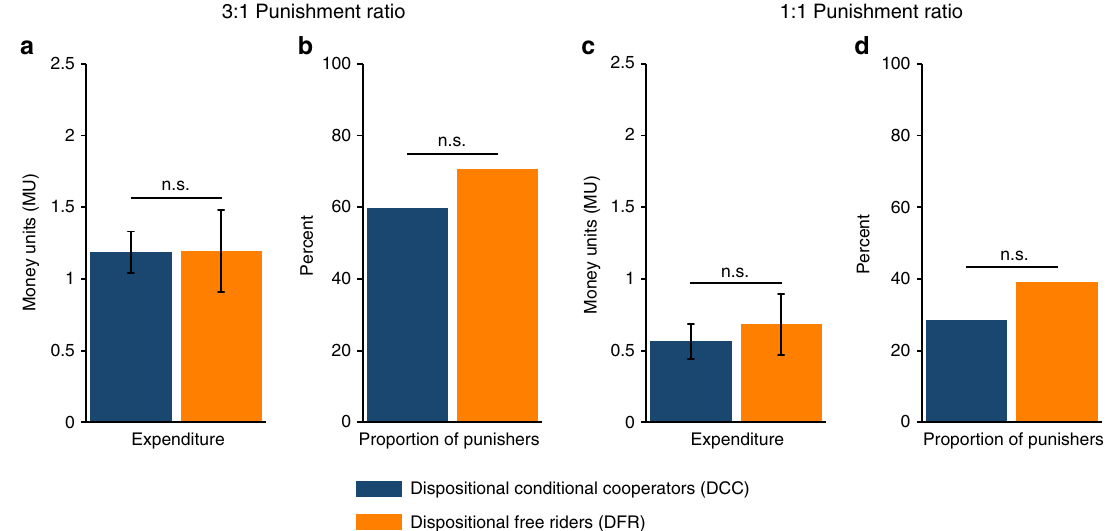
Fig. 3 Prosocial punishment behaviour of DCC and DFR in the 3:1 punishment ratio condition and the 1:1 punishment ratio condition. a Average expenditure of DCC and DFR on prosocial punishment in the 3:1 punishment ratio condition ( N DCC = 77; N DFR = 35); Mann – Whitney test, n.s. P > 0.10. b Share of DCC and DFR engaging in prosocial punishment in the 3:1 punishment ratio condition; n.s. P > 0.10, χ 2 test. c The average expenditure of DCC and DFR on prosocial punishment in the 1:1 punishment ratio condition ( N DCC = 74; N DFR = 41); n.s. P > 0.10, Mann – Whitney test. d Share of DCC and DFR engaging in prosocial punishment in the 1:1 punishment ratio condition; n.s. P > 0.10, χ 2 test. The error bars indicate ± 1